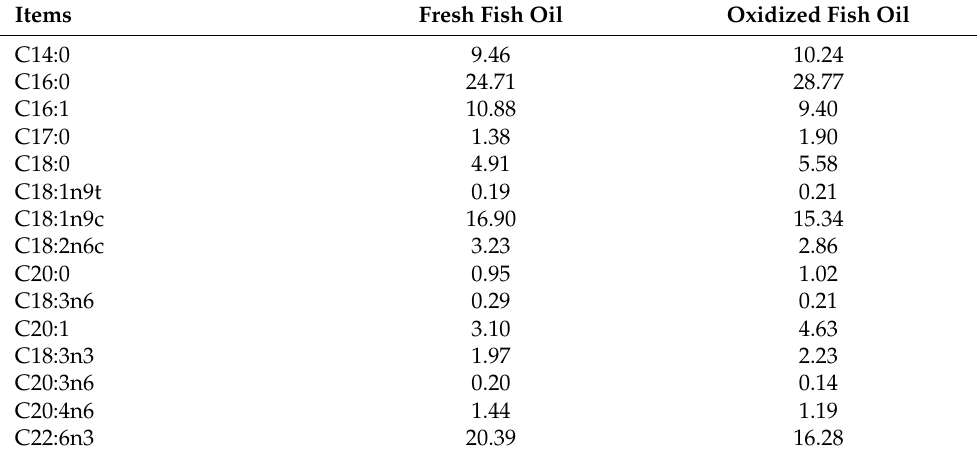
Table 1. Fatty acid composition of oxidized fish oil and fresh fish oil (% of